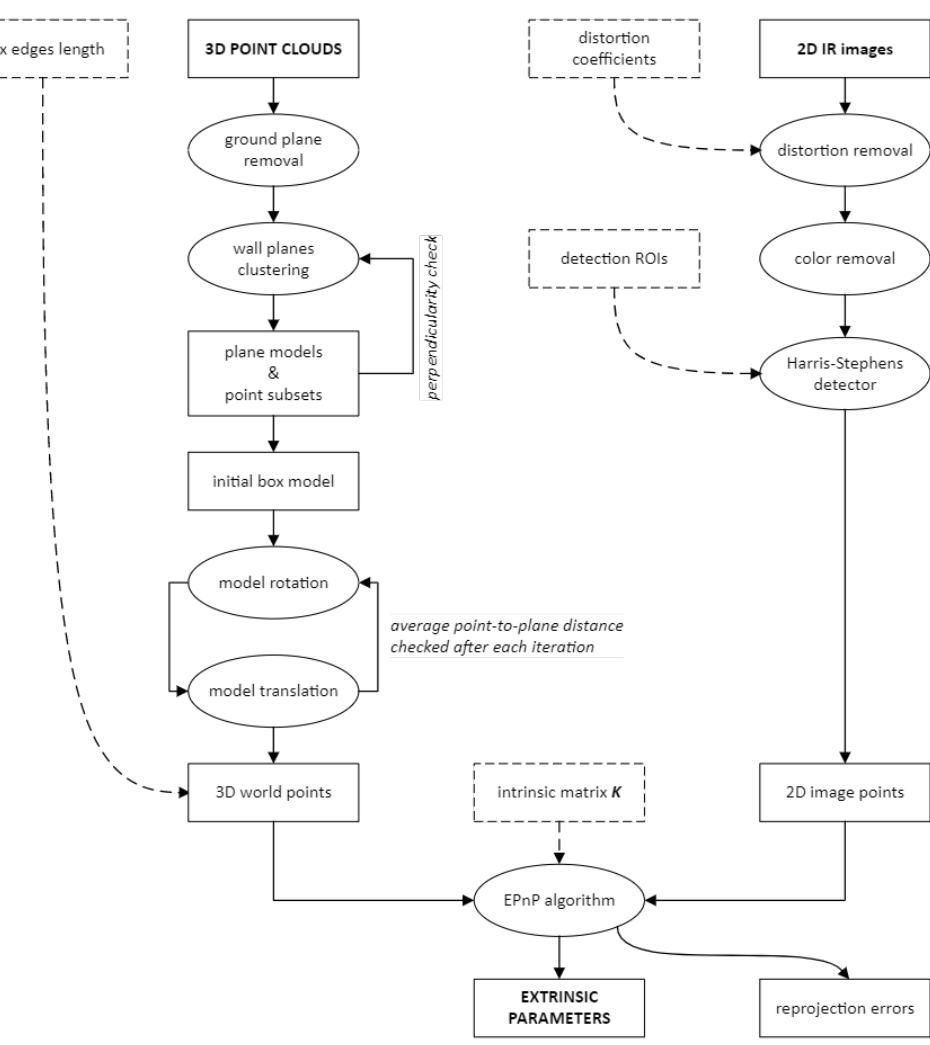
Figure 1. Block diagram of the camera-LiDAR calibration process. The algorithm takes a point cloud and a thermal image of the calibration target as input, returning the extrinsic parameters and the average reprojection error as output. The point cloud and the thermal image must have been acquired simultaneously, with the instruments in a fixed configuration. Each calibration dataset is processed separately, in order to select the one producing the lowest average reprojection